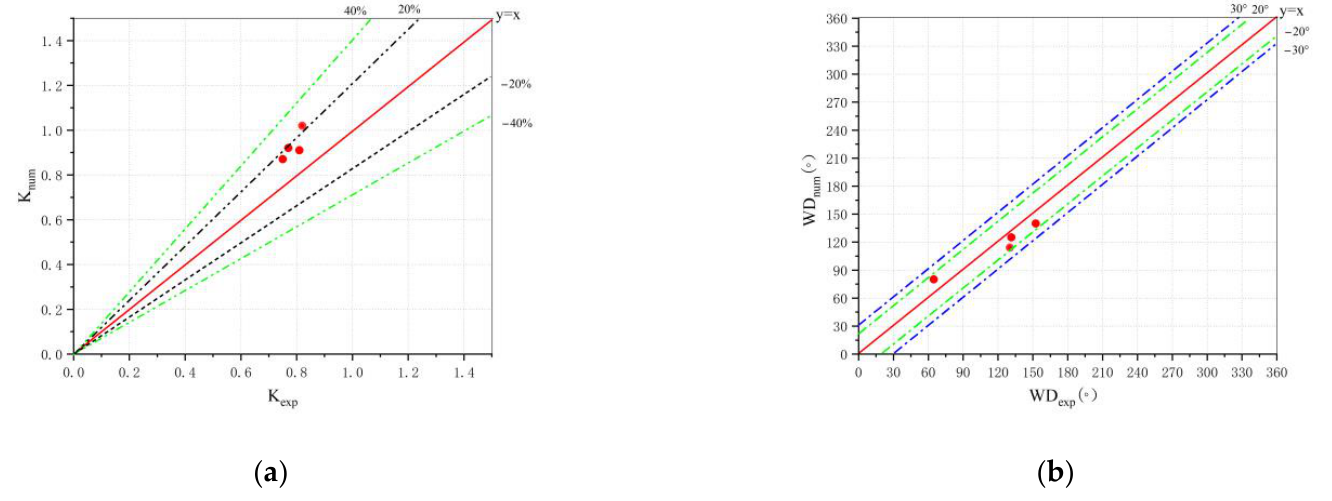
Figure 11. Comparison of the simulated and measured ( a ) wind speed ratio; ( b ) wind direction. The red dot indicates four different reference wind directions.